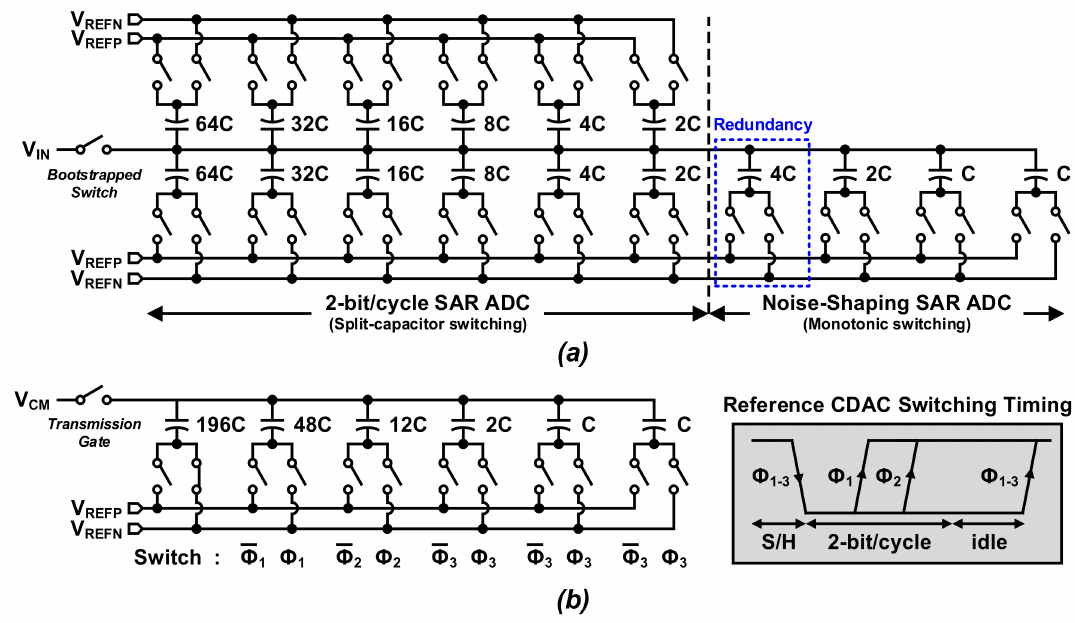
Figure 7. Schematic of ( a ) signal CDAC and ( b ) reference